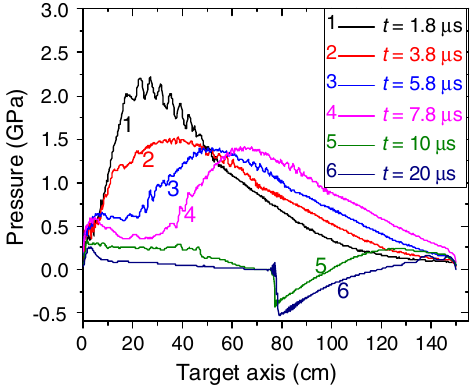
FIG. 9. Pressure along the target axis at different times of t ¼ 1 . 8 , 3.8, 5.8, 7.8, 10, and 20 μ